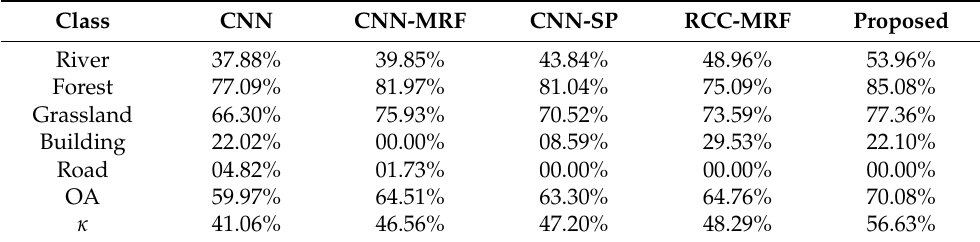
Figure 7. The classification results on the SF-Bay image. ( a ) CNN. ( b ) CNN-MRF. ( c ) CNN-SP. ( d ) RCC-MRF. ( e ) Proposed method. ( f ) Ground truth. ( d ) RCC-MRF. ( e ) Proposed method. ( f ) Ground truth. Table 6. Accuracies of classification on Lillestroem